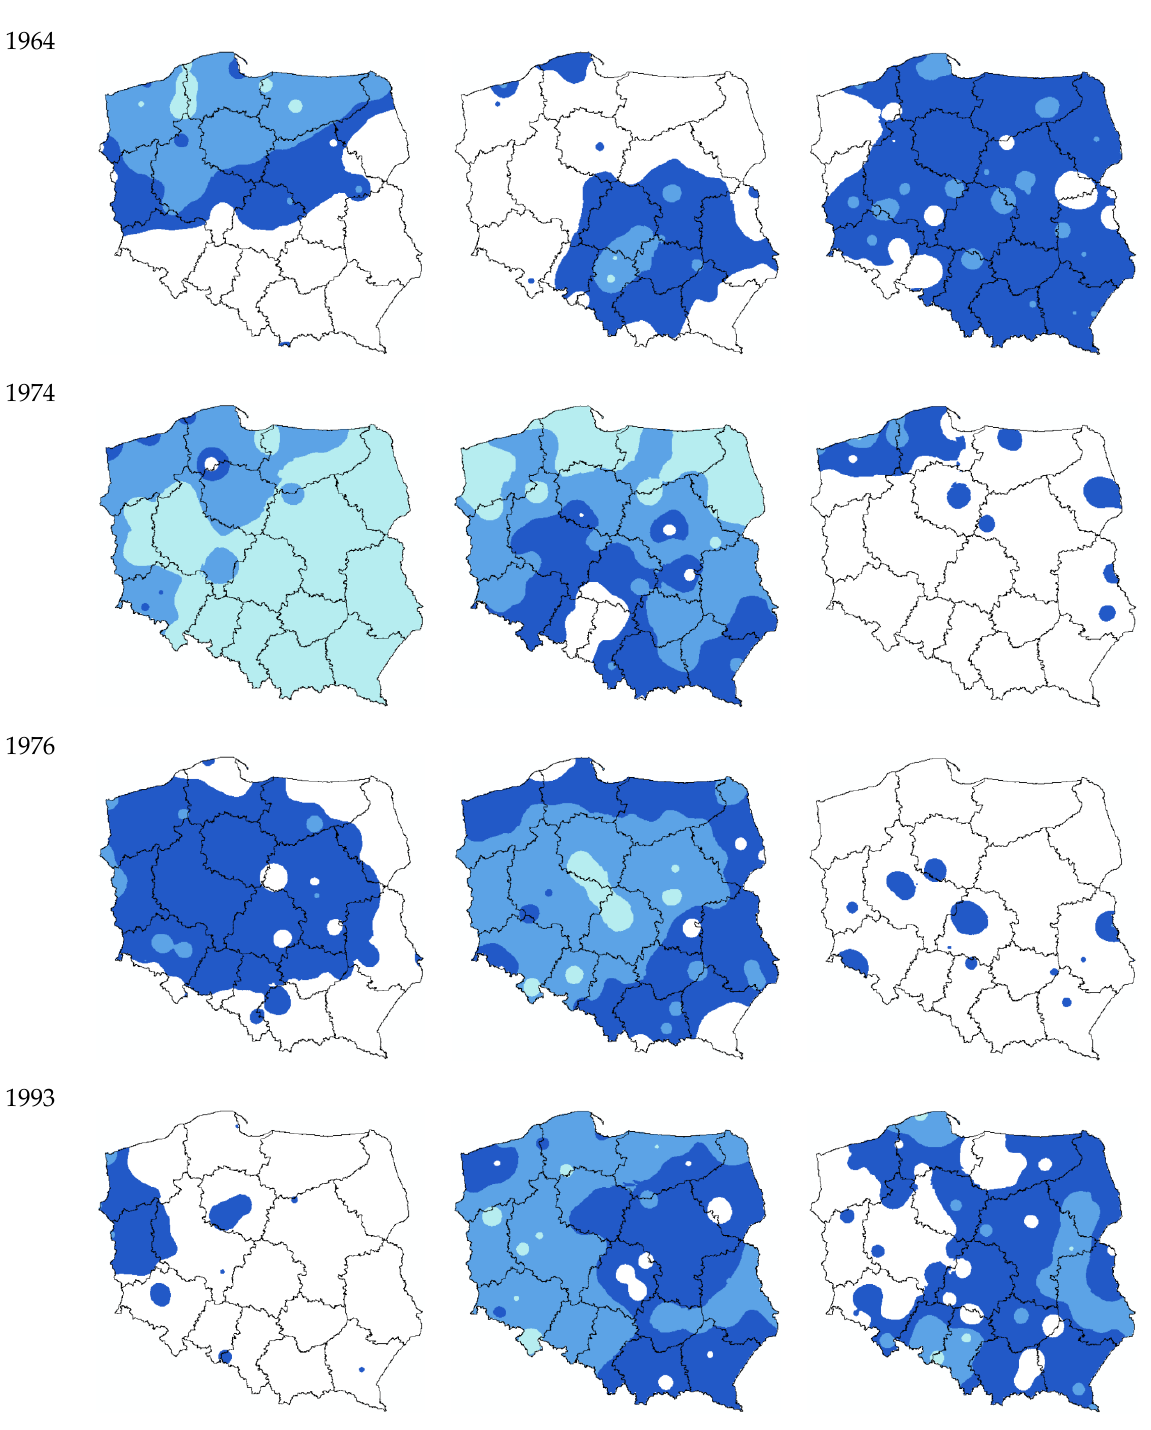
Figure 6. Spatial distribution of spring precipitation deficits of varying intensity: high ( ), medium ( ) and low ( ) in selected years of the multi-year period of 1951–2018 by month from March to May in Poland.